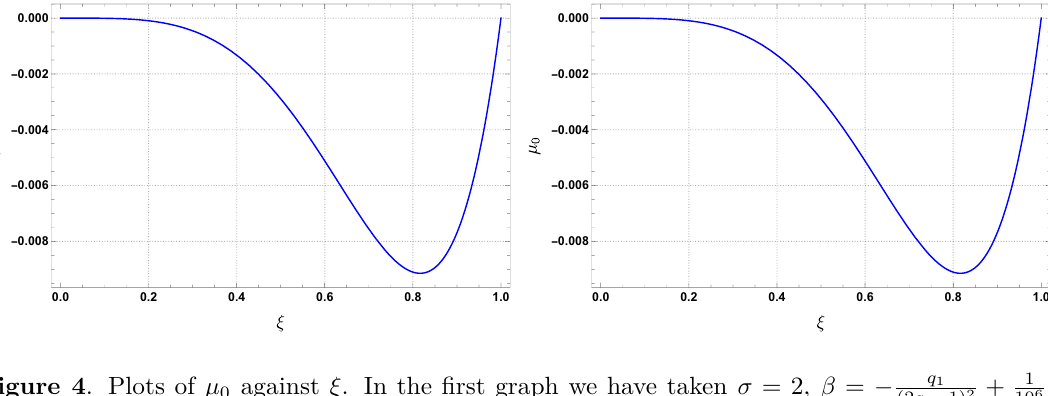
Figure 4 . Plots of µ 0 against ξ . In the first graph we have taken σ = 2 , β = − q 1 q 1 = 5 . The second graph corresponds to σ = 2 , β = − q 1